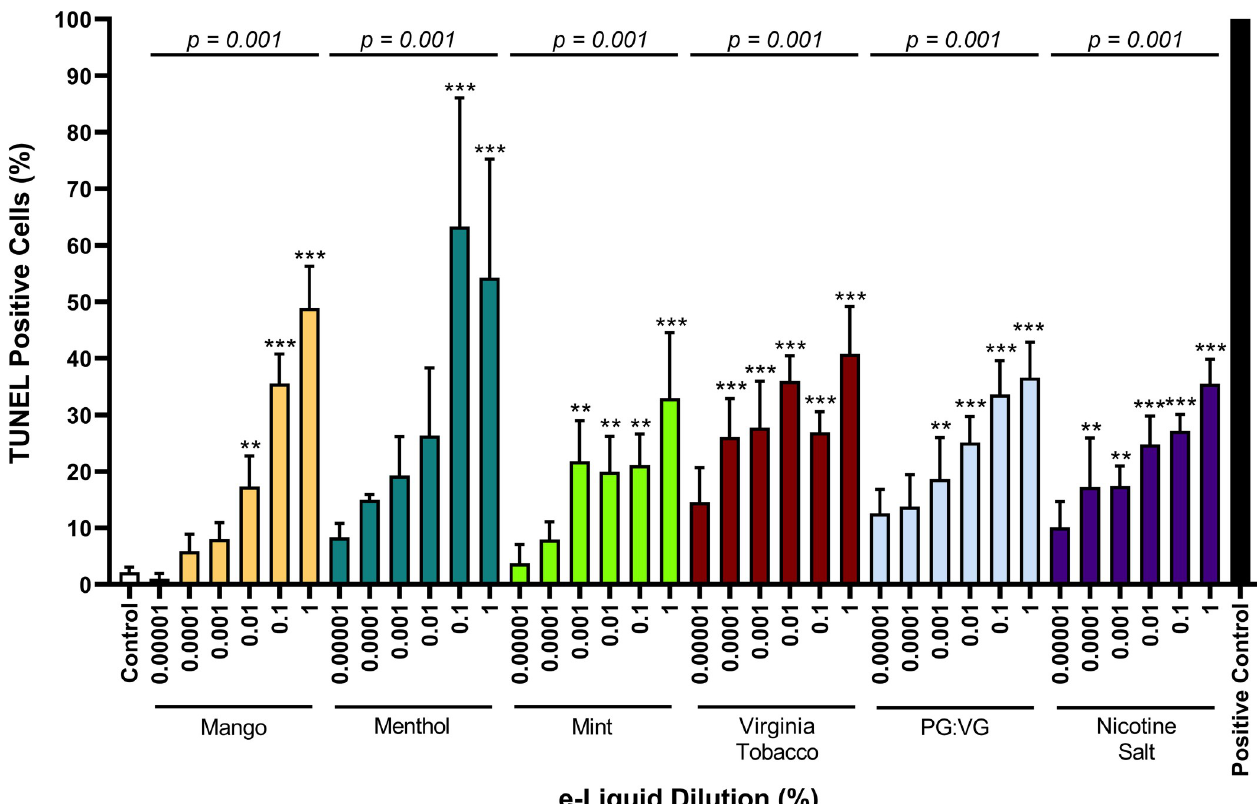
Fig 2. The JUUL e-liquid and its individual components induce cellular death. The percentage of cells staining positive for TUNEL (terminal deoxynucleotidyl transferase dUTP nick-end labeling) were assessed with dilutions from 1 x 10 − 5 to 1% (n = 3). DNase was used as a positive control. The percentage of apoptosis for all dilutions of each e-liquid were compared to control ( � indicates p < 0.05, �� indicates p < 0.01, and ��� indicates p < 0.005). Additionally, a dose-dependent nonparametric trend test was performed for each e-liquid type (indicated by horizontal line p-value). Data are plotted as mean and